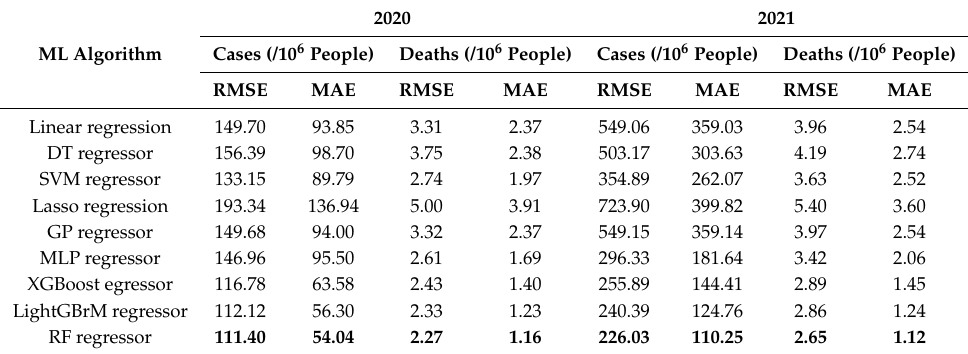
the performance evaluation of the machine learning algorithms for two different testing